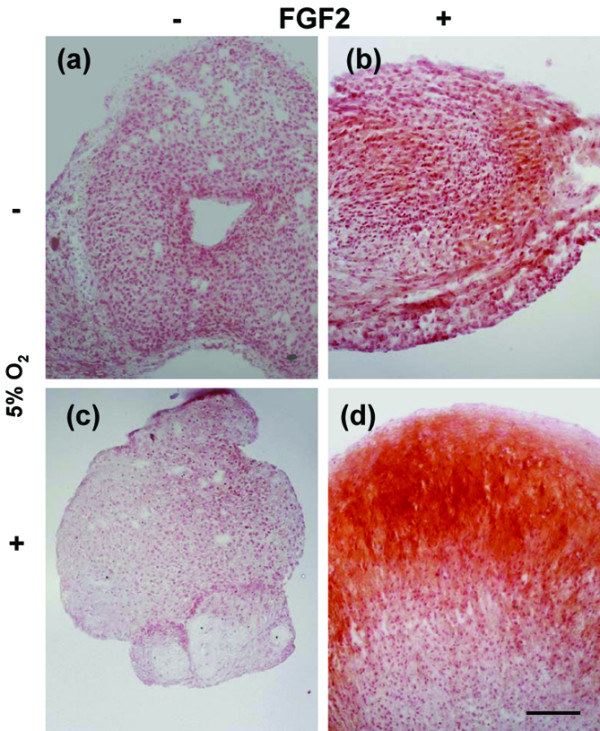
Safranin-O staining of cell aggregates. Histological analysis and matrix accumulation of cell aggregates derived from meniscus cells expanded in the absence ((a) normoxia; (c) hypoxia) and presence ((b) normoxia; (d) hypoxia) of fibroblast growth factor 2 (FGF2). Scale bar, 100 μm. FGF2, fibroblast growth factor 2.